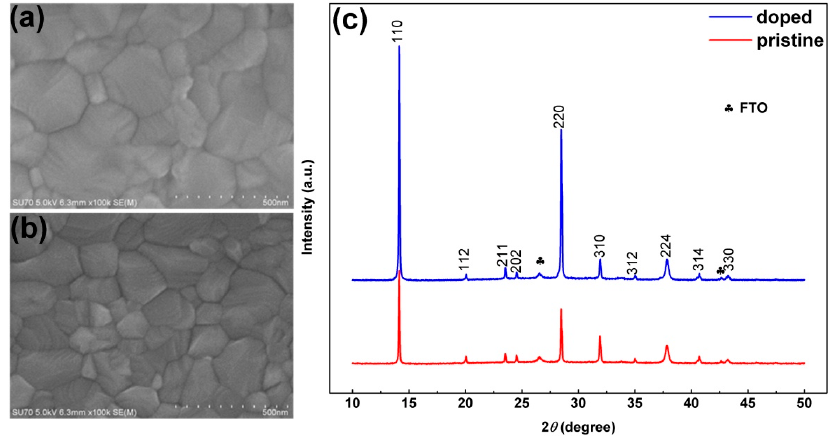
Figure 1. Comparison of material characterization between iodine-doped perovskites and pristine perovskites. ( a ) and ( b ) are the top SEM of iodine-doped perovskite and pristine perovskite, respectively; ( c ) X-ray diffraction pattern of the pristine perovskite film (the red line) and the iodine-doped perovskite film (the blue line) grown on FTO substrate.